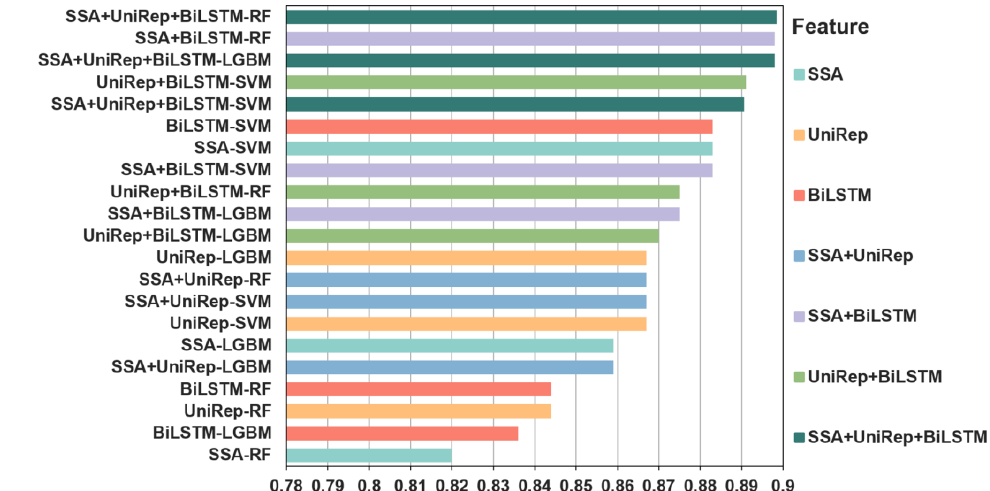
a Values representing the best performance values are in bold and are underlined. b SSA + UniRep: SSA features combined with UniRep features; SSA + BiLSTM: SSA features combined with BiLSTM features; UniRep + BiLSTM: UniRep features combined with BiLSTM features; SSA + UniRep + BiLSTM: all the above features are combined. c SVM: support vector machine; LGBM: light gradient boosting machine; RF: random forest.